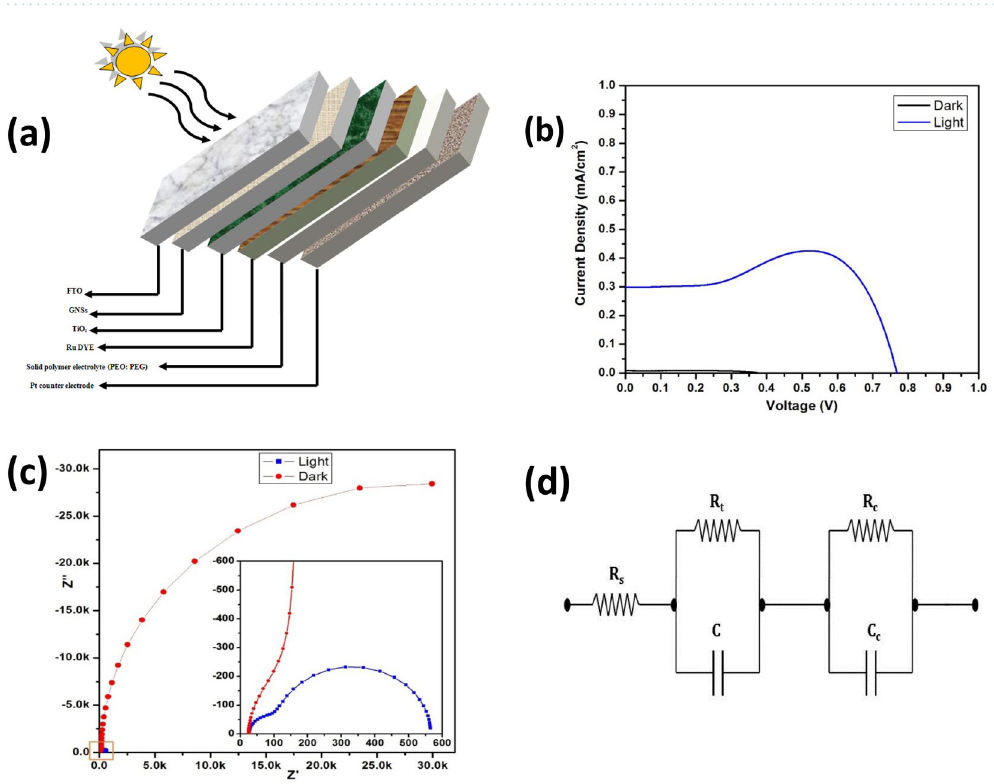
Figure 8. ( a ) Schematic of the fabricated DSSC, ( b ) J–V characteristics, ( c ) EIS curve, and ( d ) Equivalent circuit of the